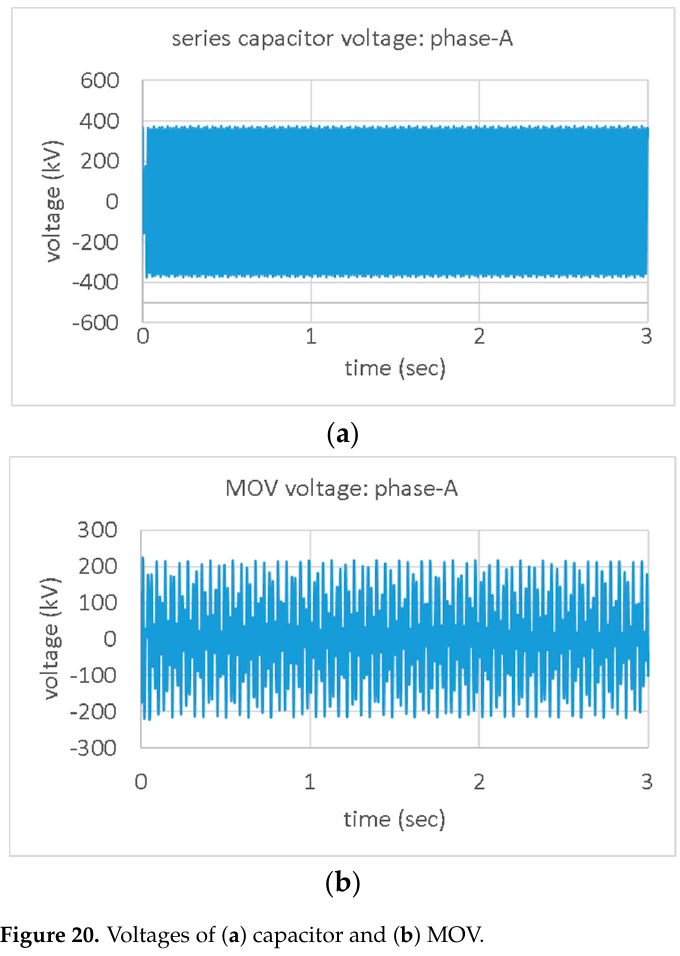
Figure 20. Voltages of ( a ) capacitor and ( b ) MOV.